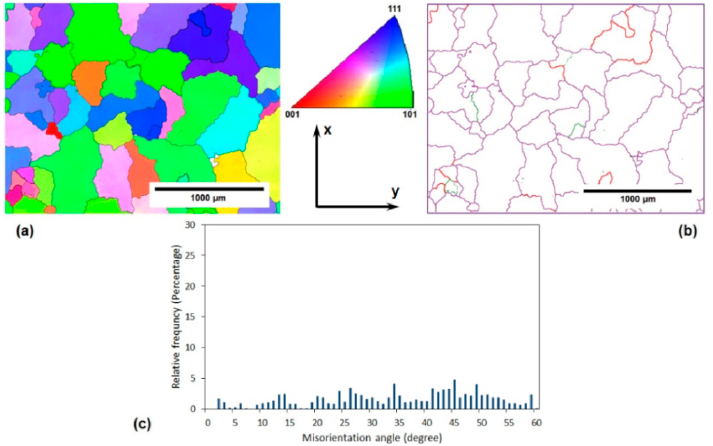
Figure 4. Microstructure features of initial solution-treated AA-6063 alloy before MFD process: ( a ) the EBSD grain orientation map, ( b ) the EBSD grain boundary map, and ( c ) the misorientation angle distribution diagram.